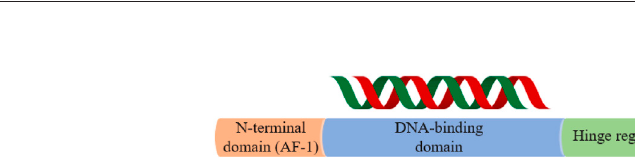
FIGURE 1 | The basic structure of nuclear receptor (NR)